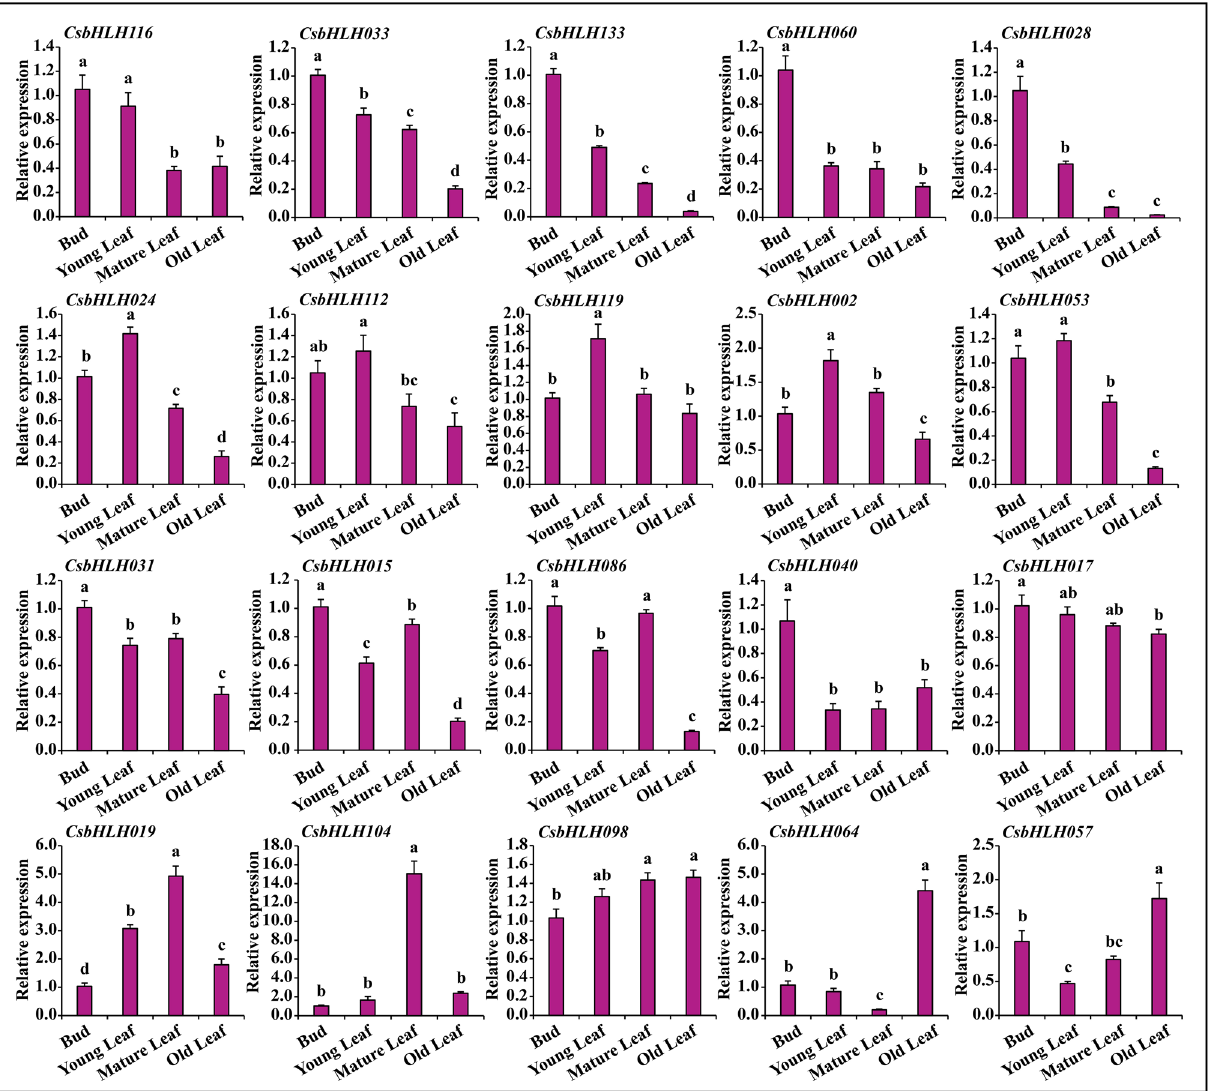
Figure 4. Expression patterns of CsbHLHs in different developmental leaf tissues in the cultivar ‘FHDC’. The different letters in the figures indicate significantly different values (P < 0.05, Tukey’s test). For all developmental leaf tissues, three biological replicates and three technical replicates of each biological replicate were